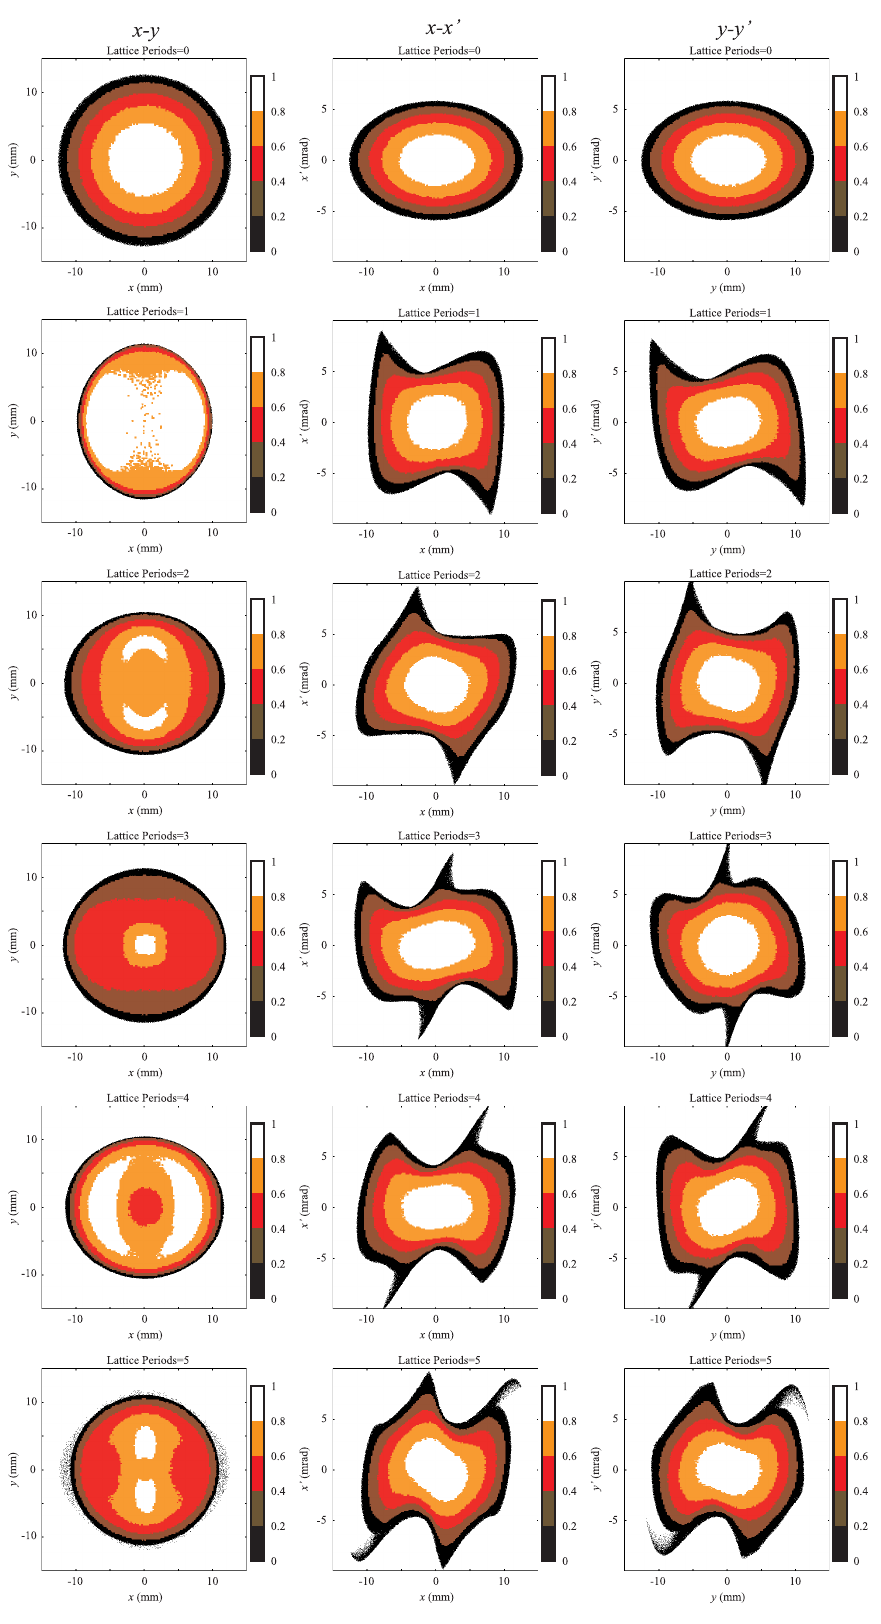
FIG. 5. (Color) Evolution of phase-space projections in x - y , x - x 0 , and y - y 0 for the initial LCS waterbag distribution shown in Figs. 3 ¼ 70 (cid:5) and (cid:3)=(cid:3) ¼ 0 : 2 . Projections (columns) are shown at lattice period intervals (rows). and 4 with (cid:3) 0 0